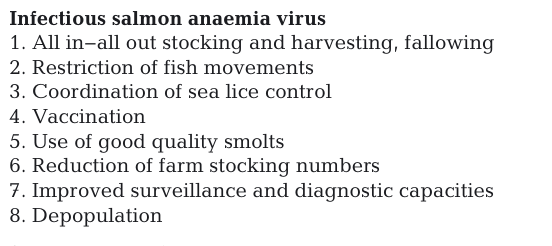
(Table 1) on the likelihood and uncertainty of each effects pathway and the consequences of pathogen spread. Definitions for descriptors of likelihood and uncertainty are given in Tables 2 & 3.